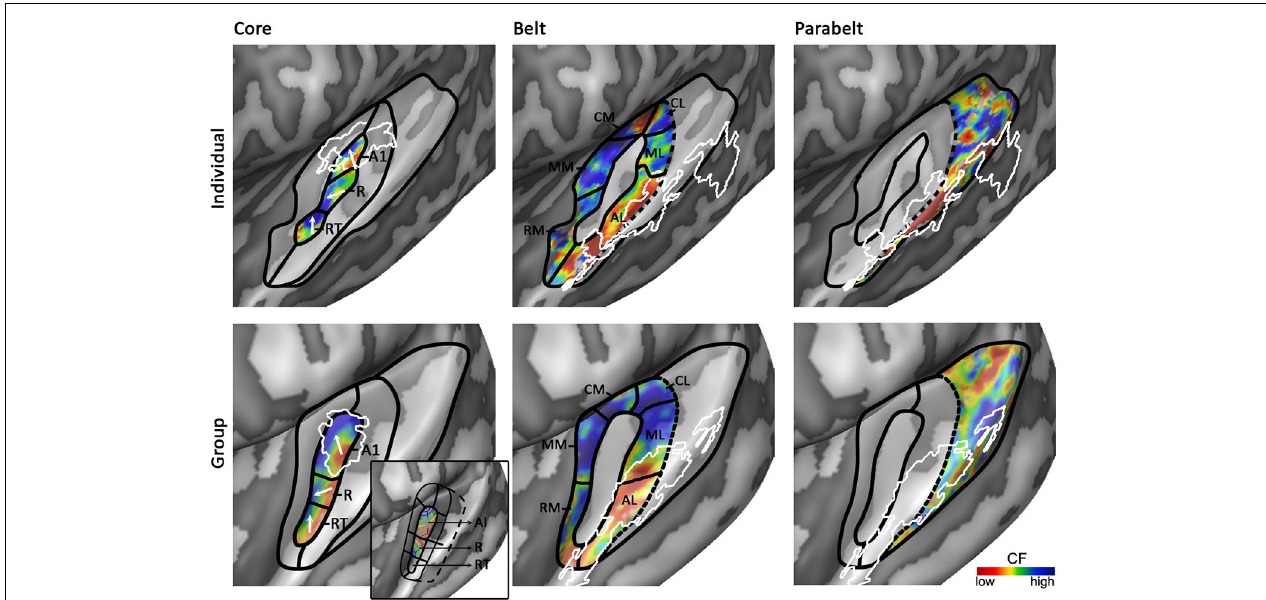
FIGURE 5 | Working model of human auditory cortex. Parcellation of the auditory cortex into core (left), medial and lateral belt (middle), and parabelt (right) based on individual ( top ) and group ( bottom ) data. Solid black lines indicate boundaries between auditory fields based on maps of tonotopy, tuning width, or myelin. Dotted black lines indicate boundaries assumed based on literature, but for which no objective measure is available. White outlines indicate maps of myelin (left) or